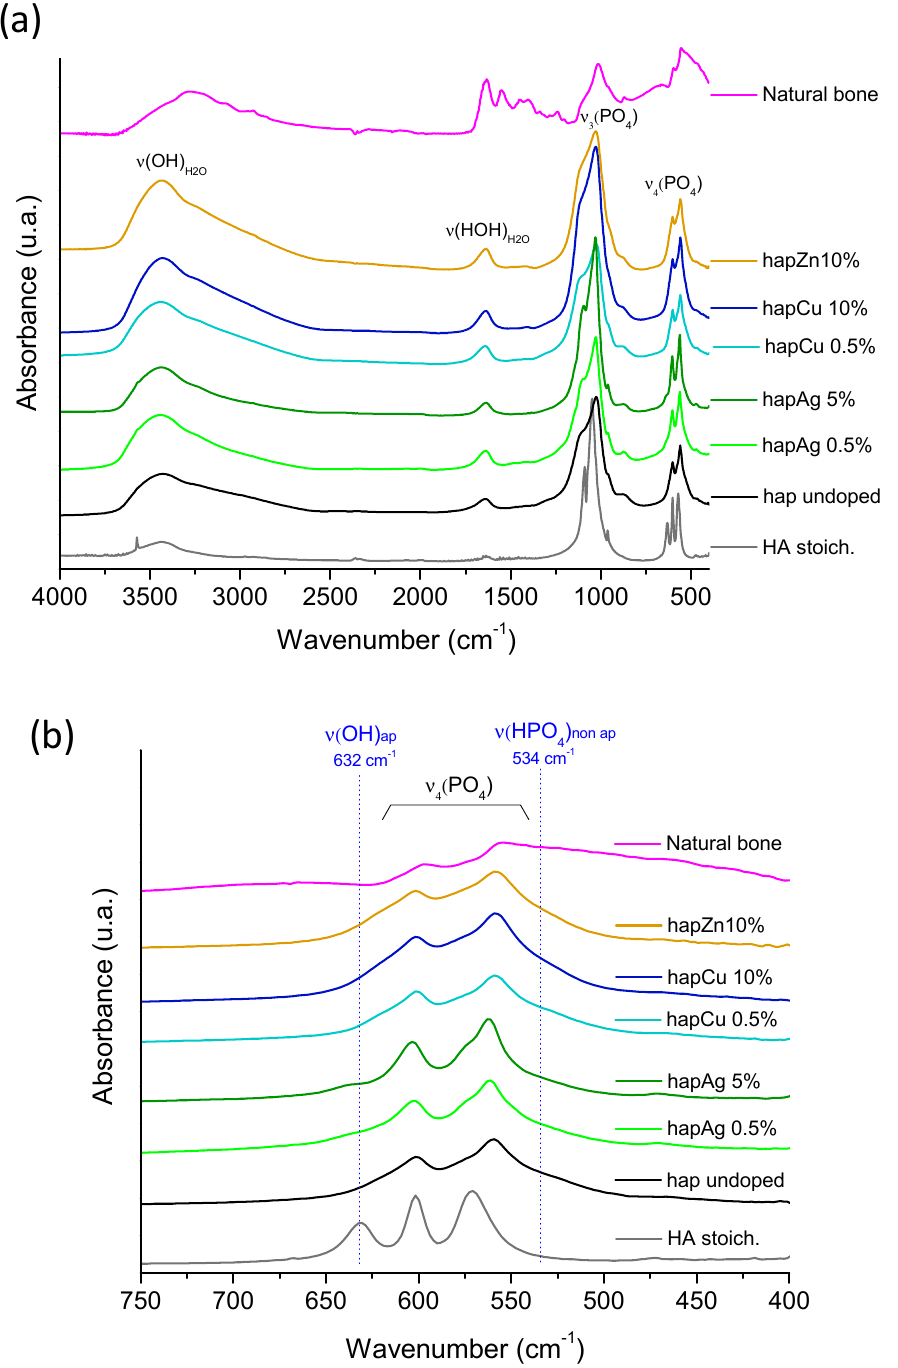
Figure 3. ( a ) FTIR spectra of the selected precipitated biomimetic apatite samples, as well as reference stoichiometric HA, undoped apatite and natural bone (rat, 9 months old, internal CIRIMAT collection), ( b ) zoom in the spectral range 400–800 cm − 1 .